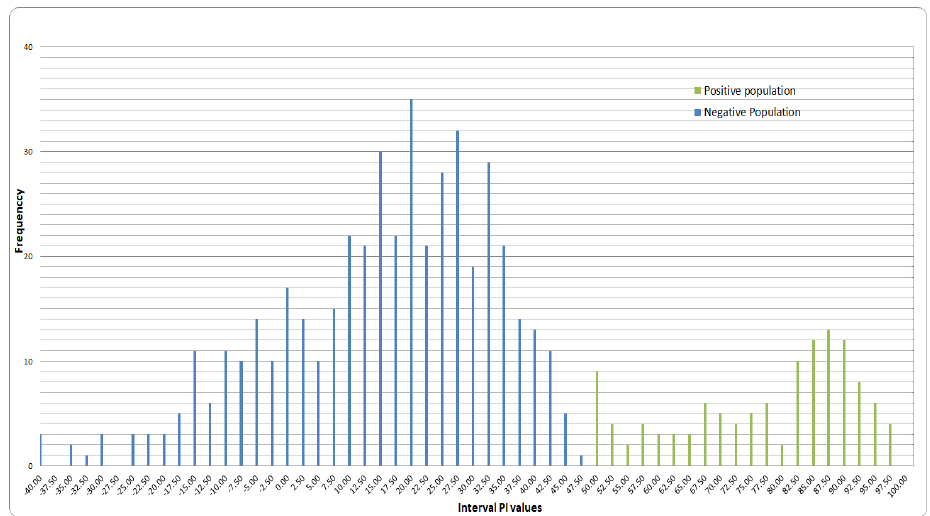
Figure 2. Distribution of Percentage Inhibition (PI) values obtained by CCPP b-ELISA for 466 negative sera samples from the negative populations (blue plots) and 84 positive sera samples from the experimentally vaccinated goats (green plots). Median value for PIs from negative population was 14.21% with standard deviations (SD) at 17.7 47. The highest PI value from the negative sera was 47.5% which was close to the cut-off value established at median value + 2 × SD (14.21 + 2 × 17.7 = 49.80 PI).